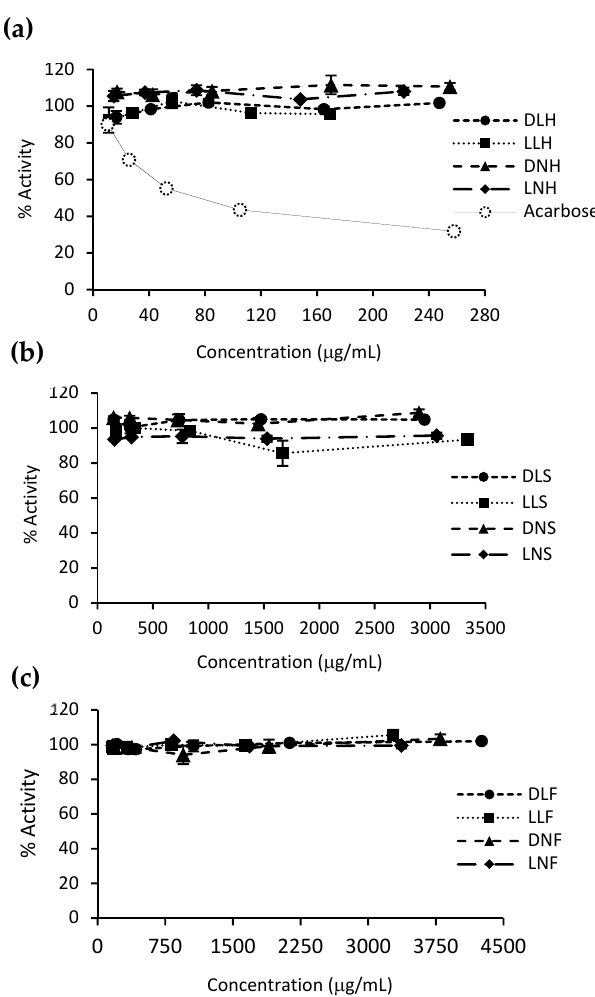
Figure 4. α -amylase inhibitory activity of D. incurvata and L. spicata PHLE extracts. The charts present the relative enzyme activity against increasing concentrations of the extracts, classified by the seaweed part origin: ( a ) holdfast, ( b ) stipe, and ( c ) frond. The acarbose inhibitory curve is also shown. Data are means ± SD of two replicates.